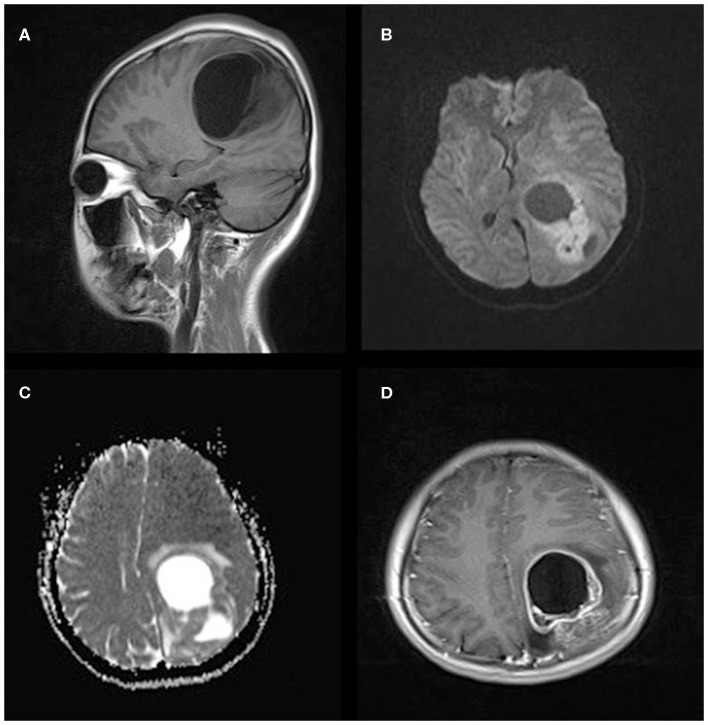
A 21-year-old woman with supratentorial intraparenchymal anaplastic ependymoma in the left parietal lobe on (A) T1-weighted image, (B) diffusion-weighted images, (C) apparent diffusion coefficient, and (D) contrast T1-weighted image. The tumor appears as heterogeneous signal intensity, large cysts, reduced diffusion within the soft tissue component, and mild peritumoral edema.